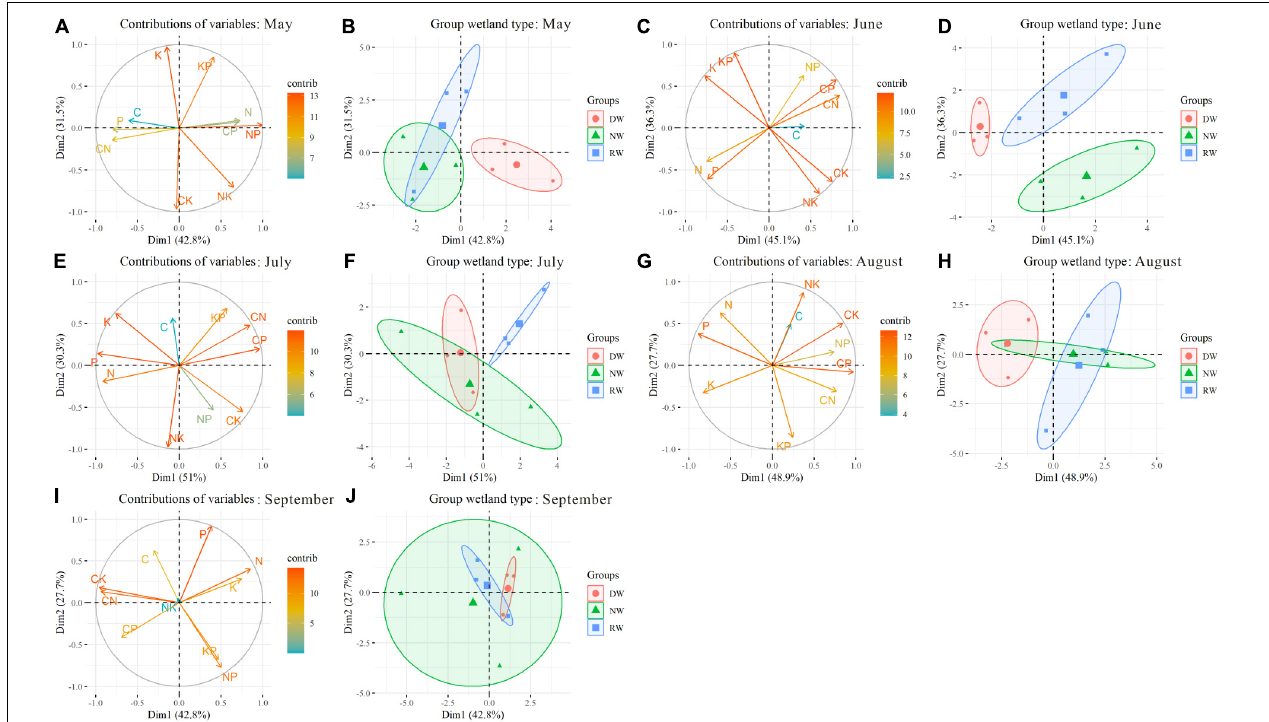
FIGURE 5 | The locations of nutrient stoichiometry in Carex schmidtii reared on wetland type during growth stages. May: (A,B) ; June: (C,D) ; July: (E,F) ; August: (G,H) ; September: (I,J) . Markers represent individual sample locations, while the ellipses represent 95% confidence interval for each group.